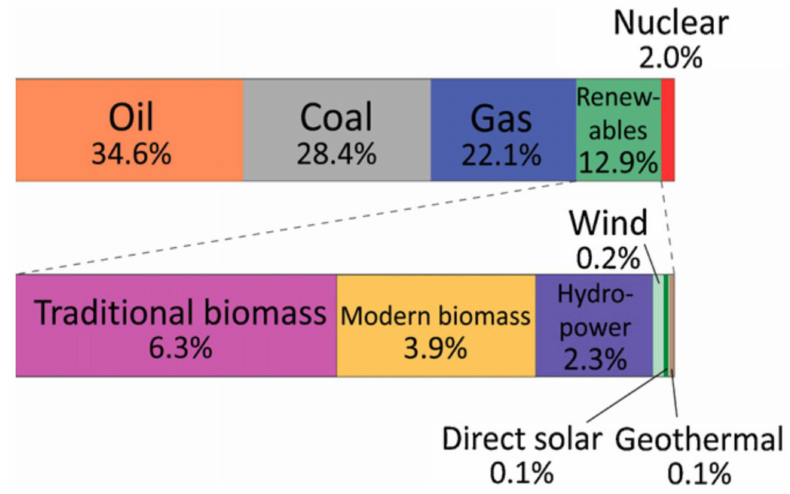
Figure 1. Distribution of energy consumption sources in 2008. Reprinted with permission from Elsevier, 25 December 2021 Ref.